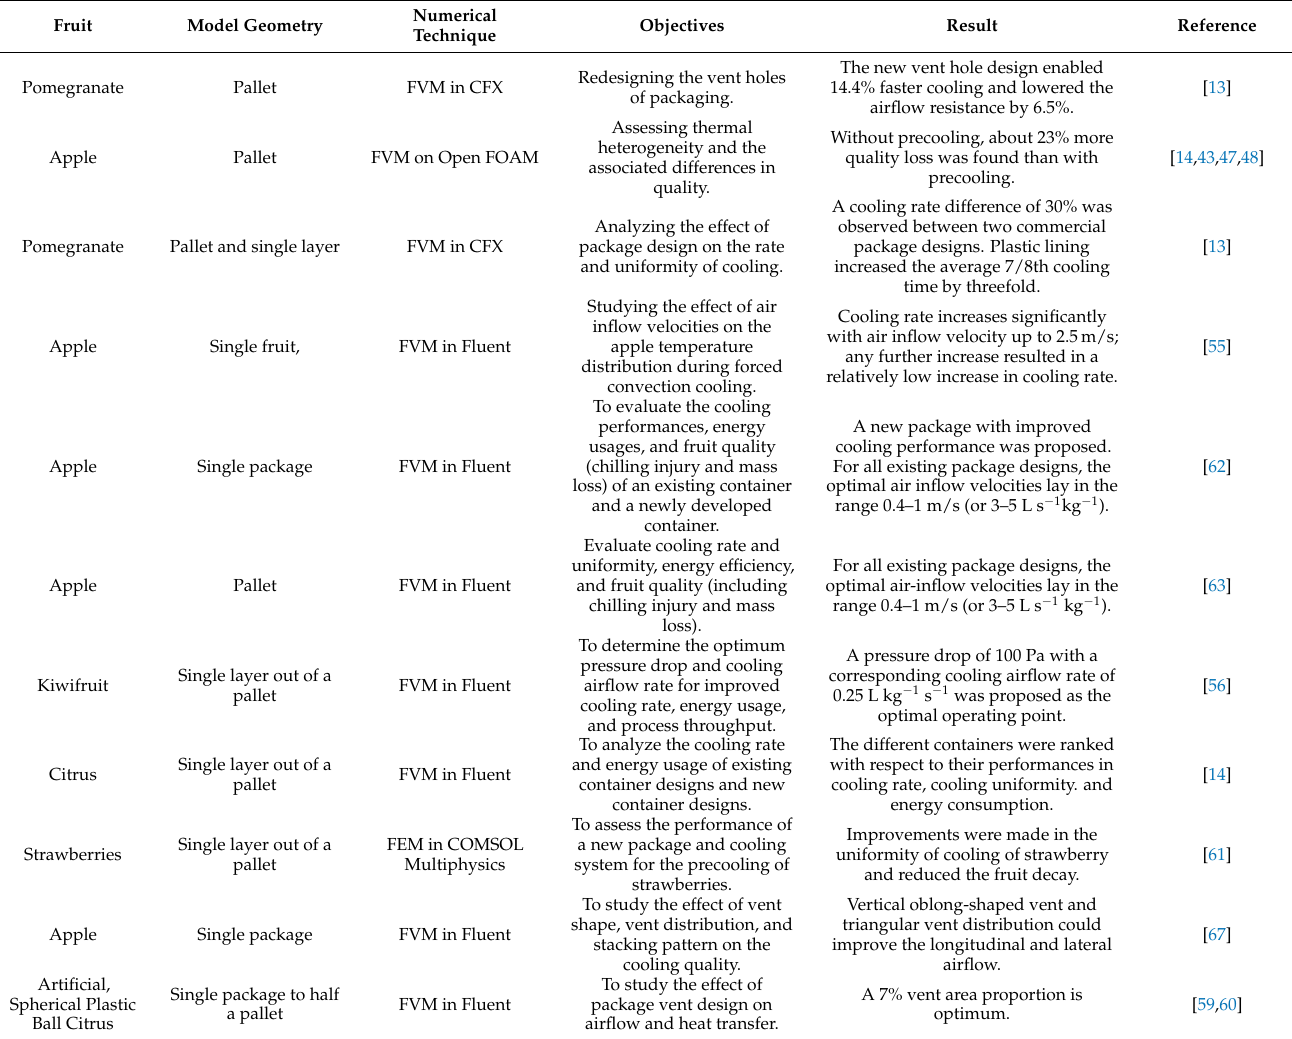
Table 2. Objectives, numerical techniques, and results of computational-fluid-dynamics-based analysis in precooling studies. Fruit Model